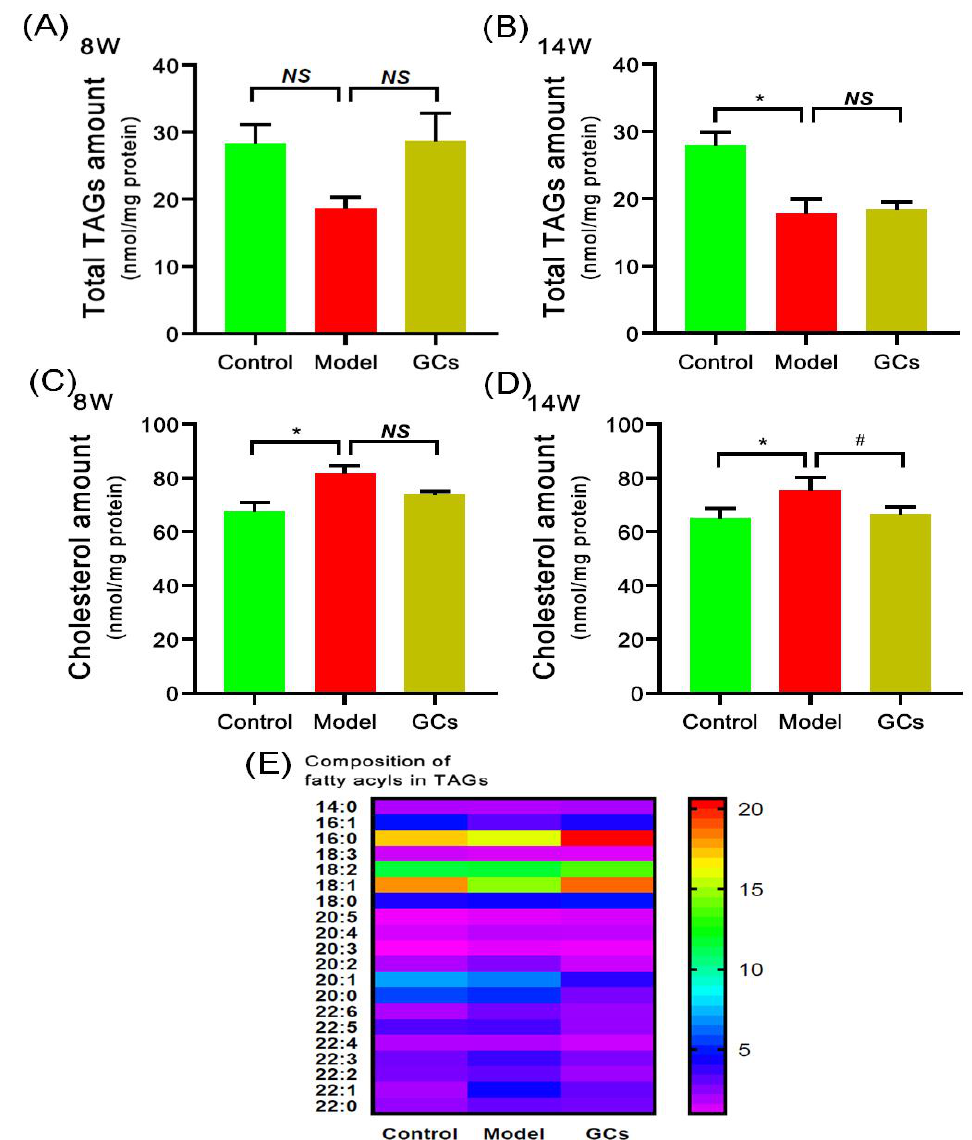
Figure 3. Comparison of the total amount of triacylglycerol species and cholesterol deposited in cardiac tissues from MRL/lpr mice from each group at different states. Heart tissues of the control ( n = 4), model ( n = 4), and GCs ( n = 4) groups were collected at 8 and 14 weeks of age, respectively. Both model and GCs groups were MRL/lpr mice, while the control group was MRL/MpJ mice. Lipidomics analysis of total level of triacylglycerol (TAG) species (Panels A and B ), composition of fatty acyls in TAGs (Panel E ), and cholesterol level (Panels C and D ) present in lipid extracts of heart was performed through multidimensional mass-spectrometry-based shotgun lipidomics. The data represent means ± SEM from different groups. Difference between the groups was determined using ANOVA followed by Dunn multiple comparison with IBM SPSS Statistics 19 Software (SPSS Inc., Chicago, IL, USA) after the normality of each group of variables was checked by Q–Q plots. The raw p values were adjusted to false discovery rat using the Benjamini–Hochberg method. * adjusted p < 0.05 and # adjusted p < 0.05 compared with those in the control group and the model group, respectively. NS , not significant.